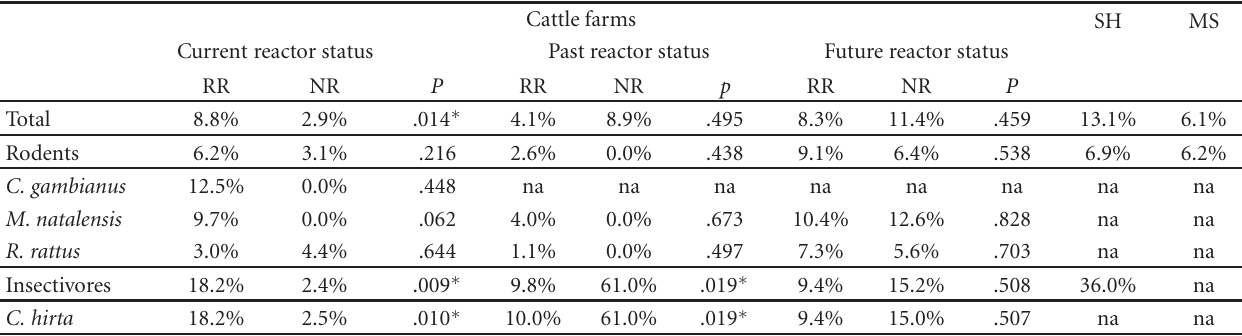
Table 5: Prevalence of mycobacteria in rodents and insectivores trapped on cattle farms, around the slaughterhouse and in Mwembesongo. RR: positive tuberculin reactor status; NR: negative tuberculin reactor status. The P values given are significance values for the di ff erence between RR and NR